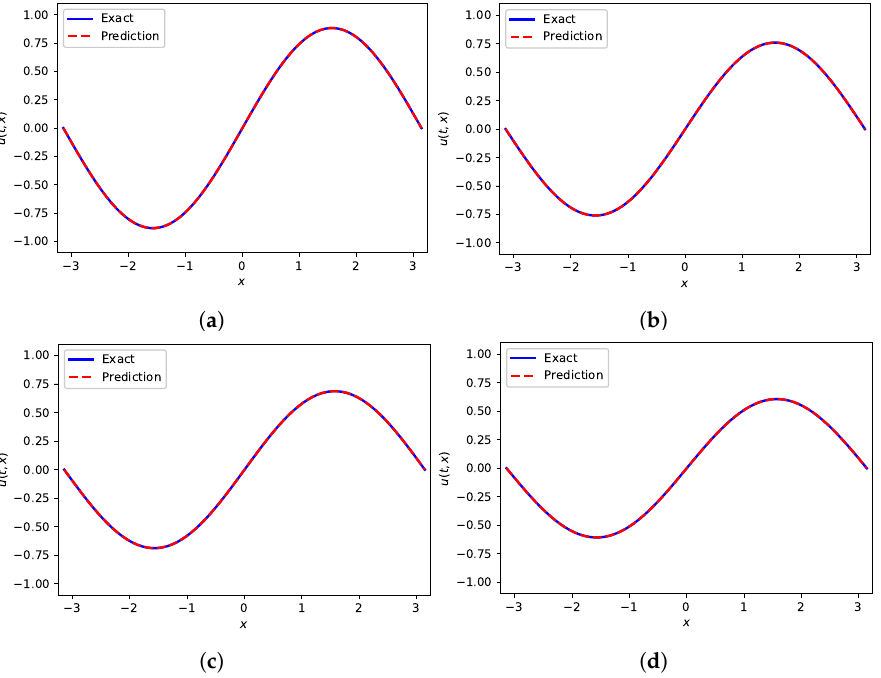
Figure 8. Comparison of predicted solution and exact solution of Equation (28) corresponding to different temporal snapshots. ( a ) t = 0.25; ( b ) t = 0.55; ( c ) t = 0.75; ( d ) t =